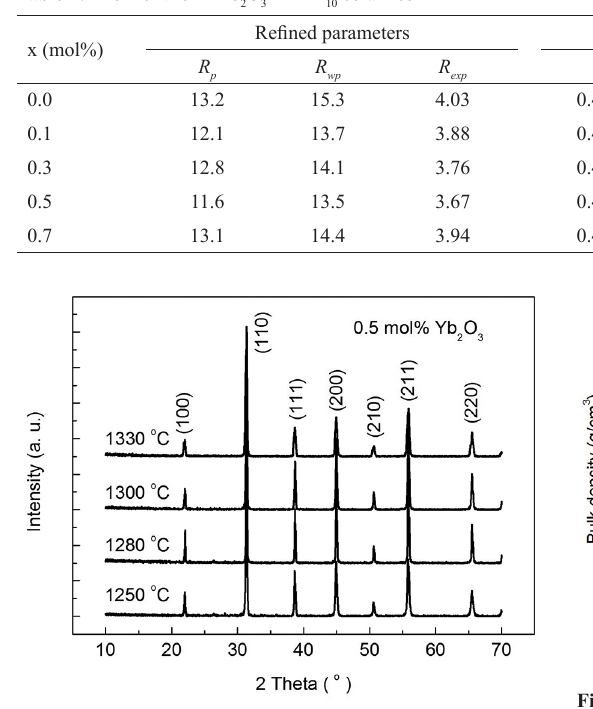
O ceramics at 2 3